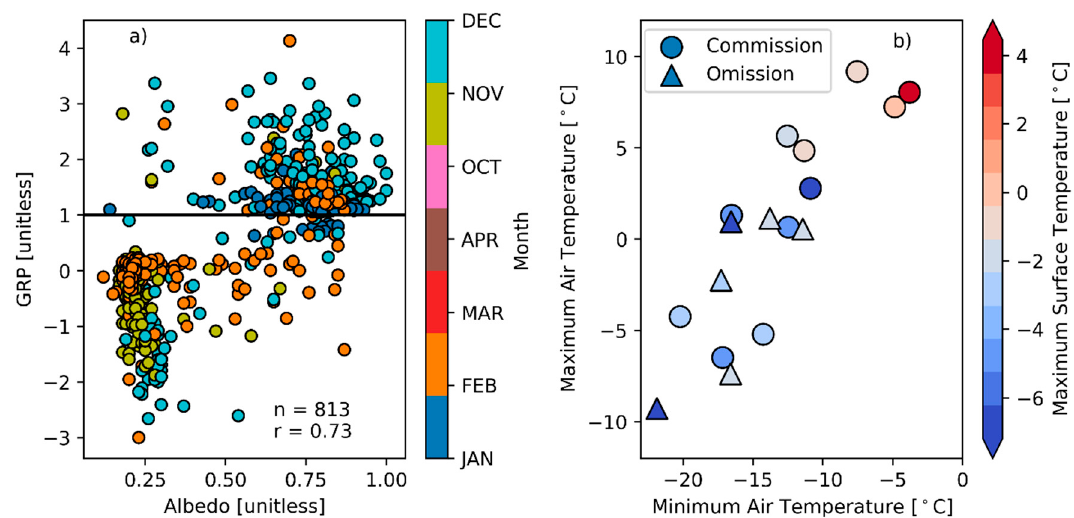
Figure 5. The left panel ( a ) plots in situ daily surface albedo at the Sugnuguur Valley site and collocated satellite PM-derived GRP values (n = 813), colored by month. The right panel ( b ) plots minimum and maximum temperature for 17 detected melt events at the same